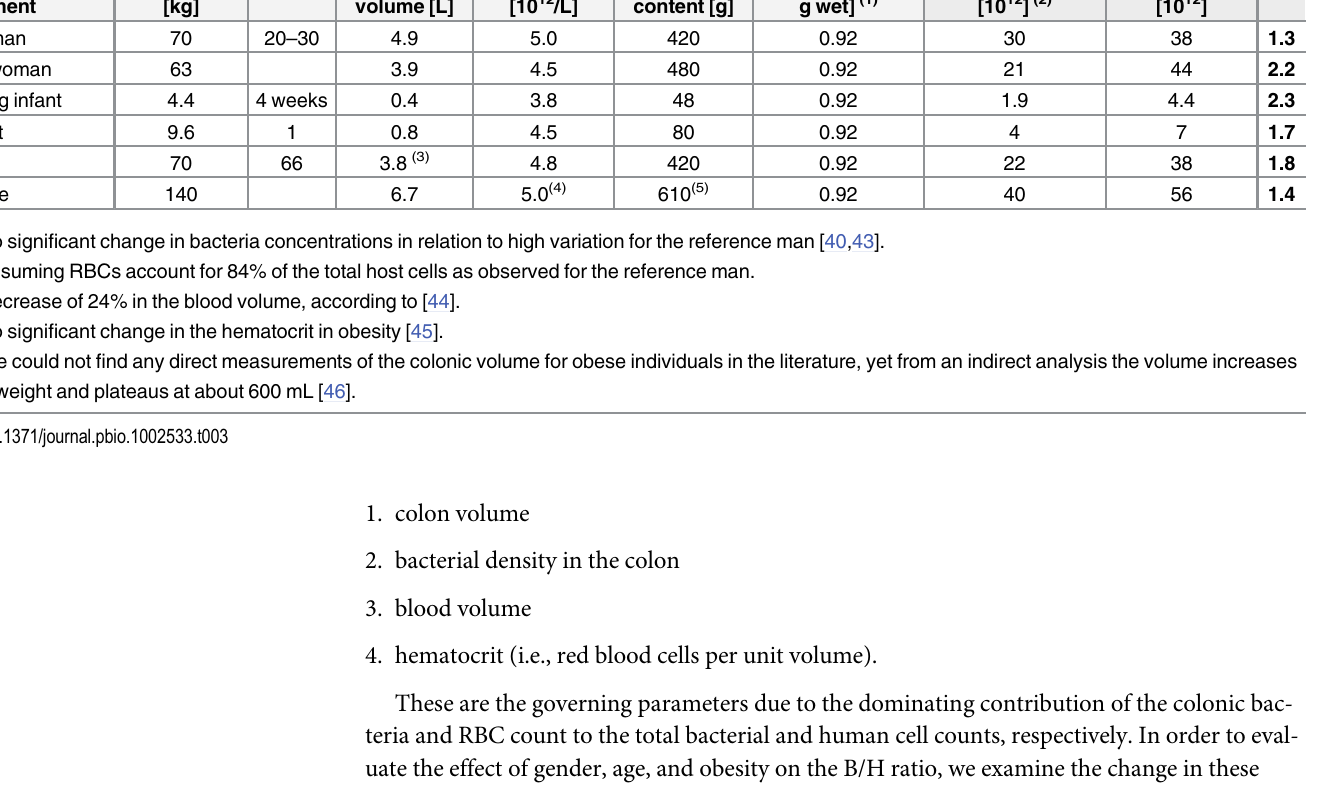
Table 3. B/H ratio for different population. See Table B in S1 Appendix for full references. population